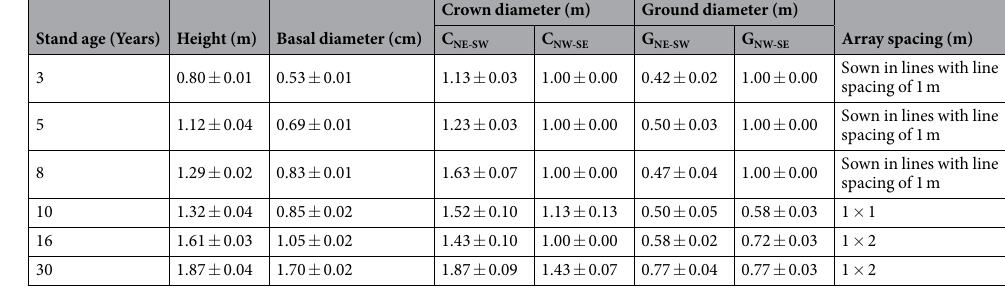
Table 4. The morphological characteristics of C. intermedia plantation stands of different ages. C NE-SW , crown diameter in the northeast-southwest direction; C NW-SE, crown diameter in the northwest-southeast direction; G NE-SW , ground diameter in the northeast-southwest direction; G NW-SE , ground diameter in the northwest- southeast direction. The values are the means ± SE (n =